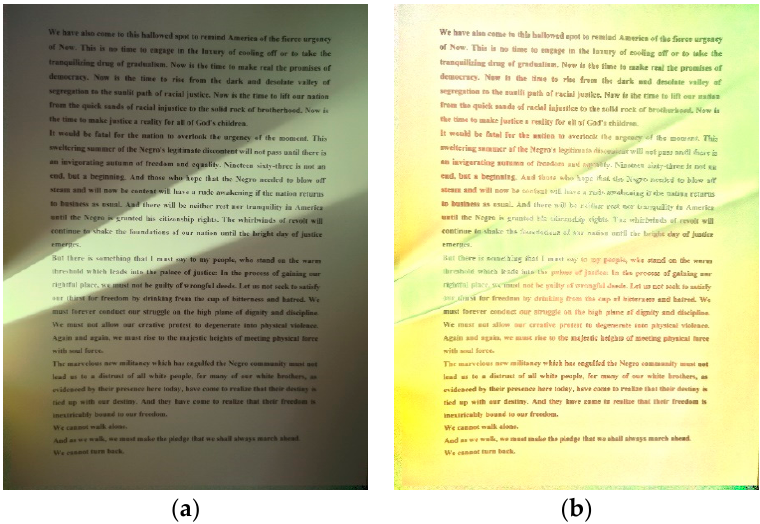
Figure 10. ( a ) High dynamic range (HDR) tone mapping operators (TMOs) with the ReinhardTMO method; ( b ) HDR TMOs with the DurandTMO method.